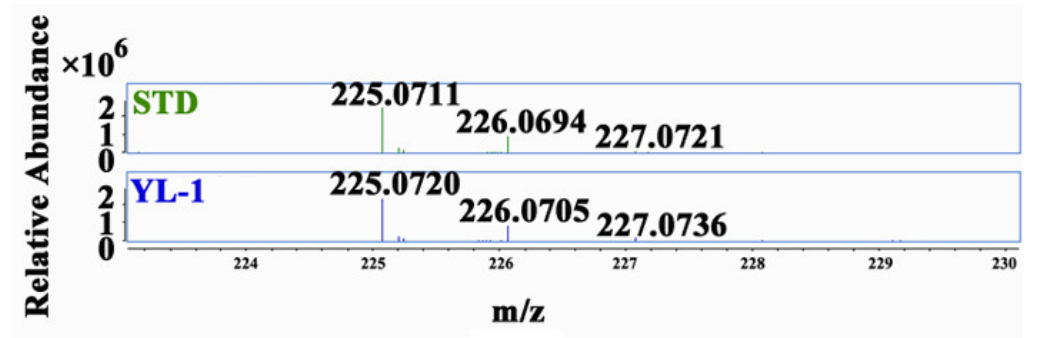
Figure 2. Reversed phase ( RP)-HPLC chromatograms. An overlay of the chromatograms at 254 nm of STD sample (blue) and the final extraction step of the wild-type YL-1 (pink) ( a ), mutants Δ phzE (green), and Δ phzF (black) ( b ), using an XDB-C18 reversed-phase column (4.6 mm  150 mm, 5 μm, Agilent), is shown. Here, STD sample (blue) was used as a positive control. The samples were eluted with acetonitrile (ACN)-5 mM ammonium acetate (60:40, v / v ) at a flow rate of 0.7 mL/min. The ex- periment was repeated three times.